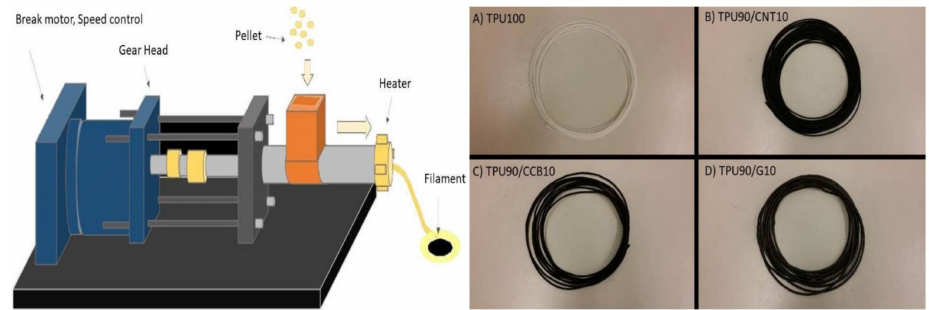
Figure 1. Schematic diagram of the filament extruder ( left ) for mixing the injected carbon black (CCB), carbon nanotube (CNT), graphite (G) with thermoplastic polyurethane (TPU_ and extruded filaments samples; ( A ) TPU100, ( B ) TPU90 / CNT10, ( C ) TPU90 / CCB10, and ( D ) TPU90 / G10 ( right